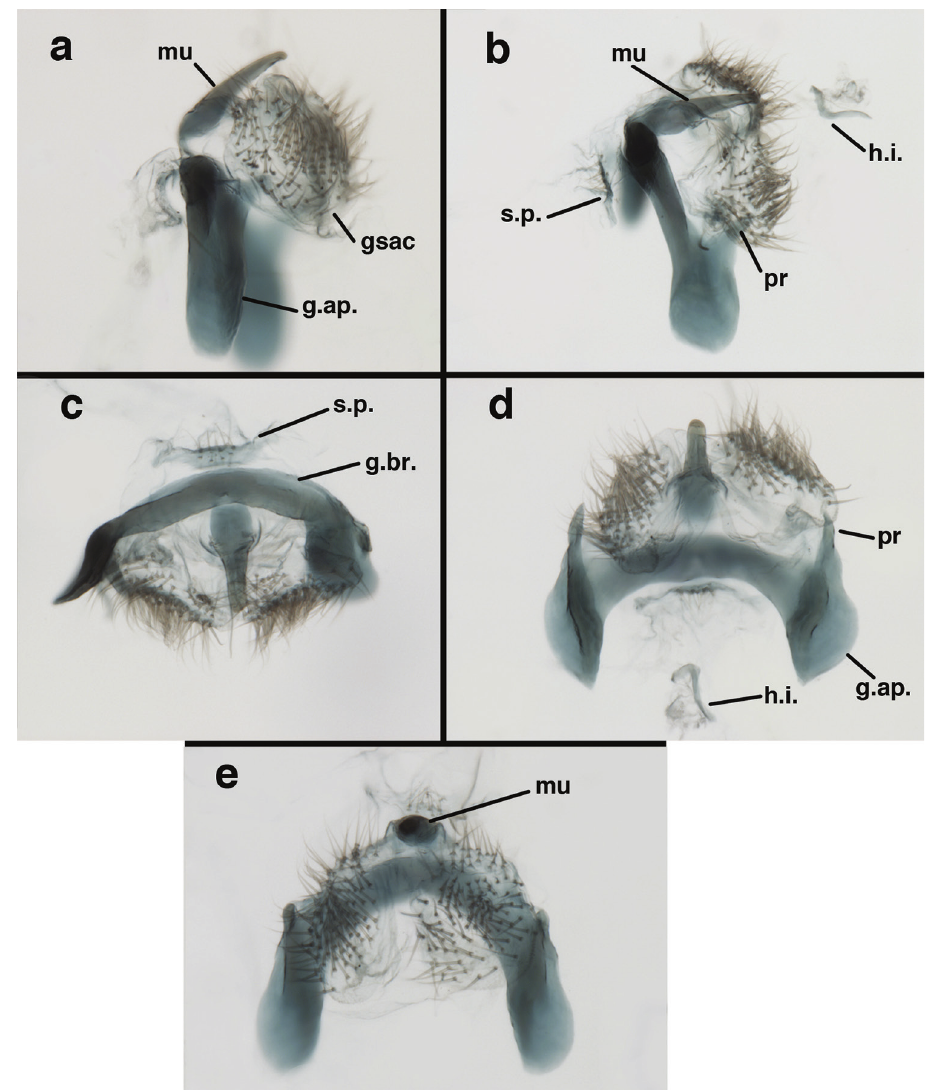
Figure 34. Ungla diazi Sosa: Male genitalia, ( a ) gonarcus, lateral ( b ) gonarcus, dorsolateral ( c ) gonar- cus, dorsal ( d ) gonarcus, ventral ( e ) gonarcus, frontal. g.ap. gonarcal apodeme g.br. gonarcal bridge gsac gonosaccus h.i. hypandrium internum mu mediuncus pr unarticulated process on frontal margin of gonarcal apodeme s.p. setose subanal plate (all: Bolivia, Cochabamba,